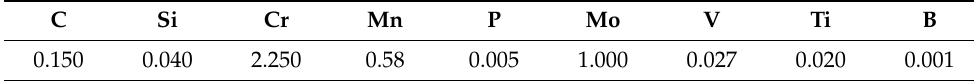
Table 1. Chemical composition of 2.25Cr1Mo0.25V steel (wt %).